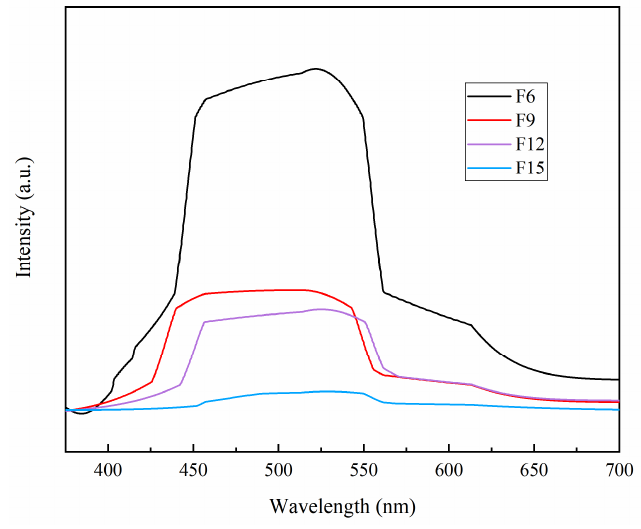
Figure 8. PL diagram of the samples.